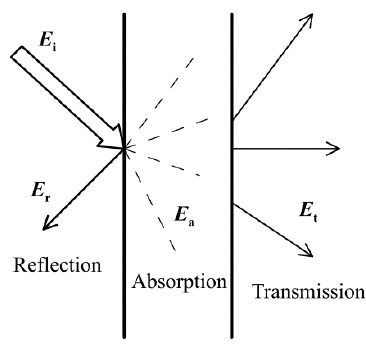
Figure 2. Distribution of the incident energy.